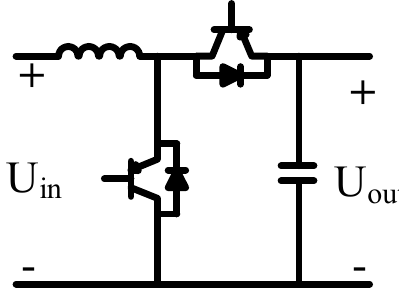
shown in Figure 6.